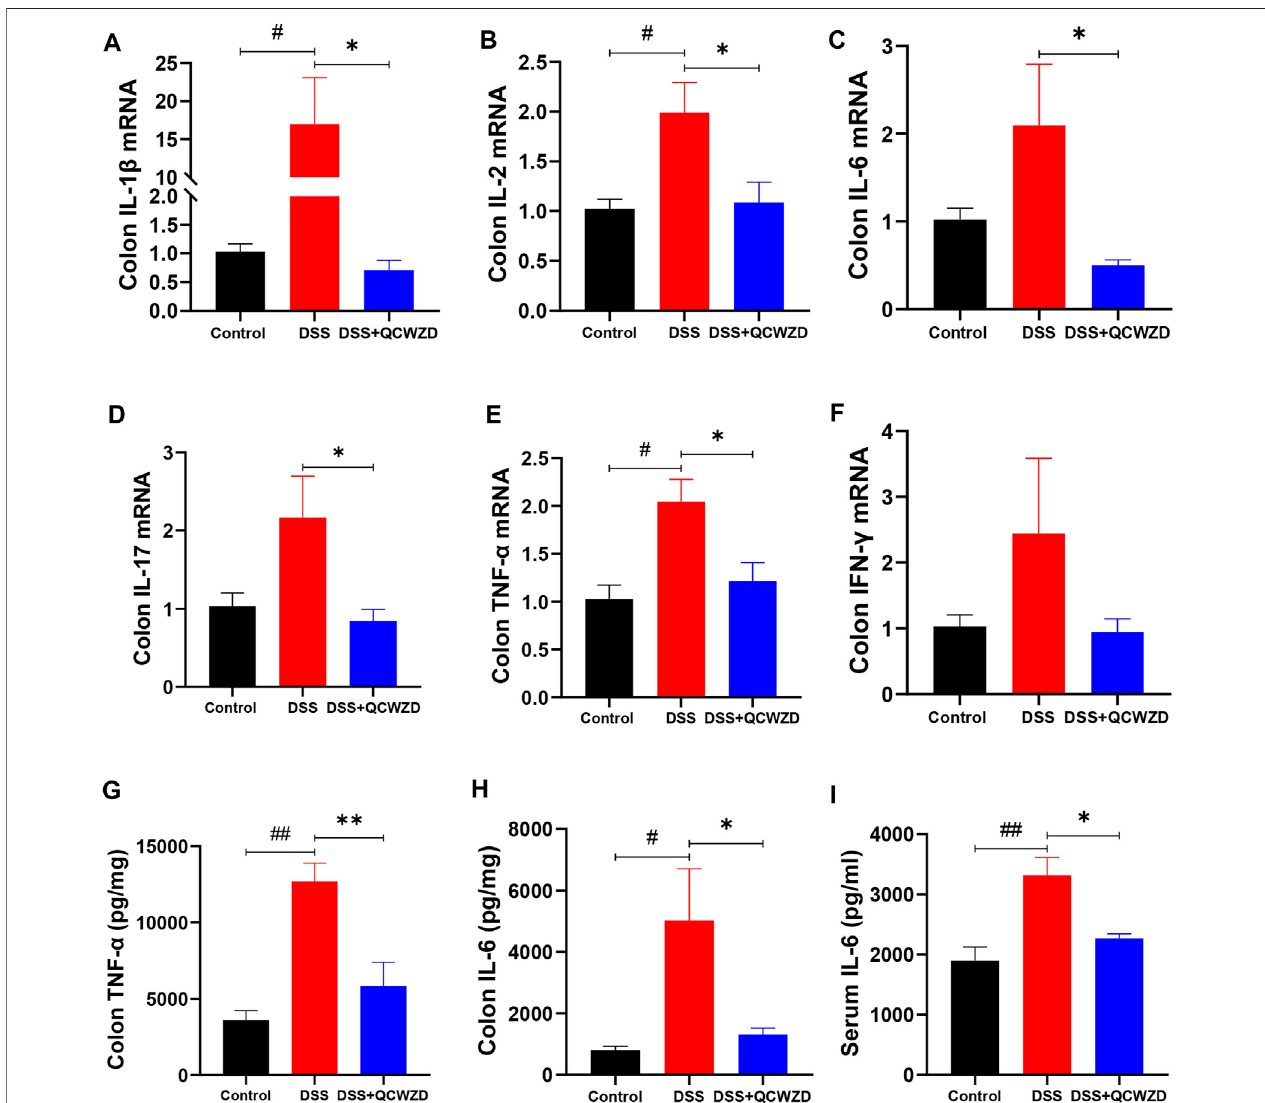
FIGURE 2 | QCWZD Mitigates DSS-Induced Intestinal Injury and Mucosal In fl ammation in Mice. Colon and serum samples were isolated from the mice with DSS- induced colitis that had been treated with QCWZD or vehicle control, and in fl ammatory related cytokines were detected using RT-qPCR and ELISA. RT-qPCR analysis forcolonicIL-1 β ,IL-2,IL-6,IL-17,TNF- α ,andIFN- γ (A – F) .ELISAanalysisforTNF- α andIL-6incolonandserum (G – I) .Thedatashownarethemean ± theSEM( n (cid:2) 4 – 6 mice/group)fromoneofthreeexperimentsperformedshowingsimilarresults. ## p < 0.01, # p < 0.05versustheControlgroup; pp p < 0.01, p p < 0.05versustheDSS group. Signi fi cance was determined by one-way ANOVA test (Tukey ’ s multiple comparison test).